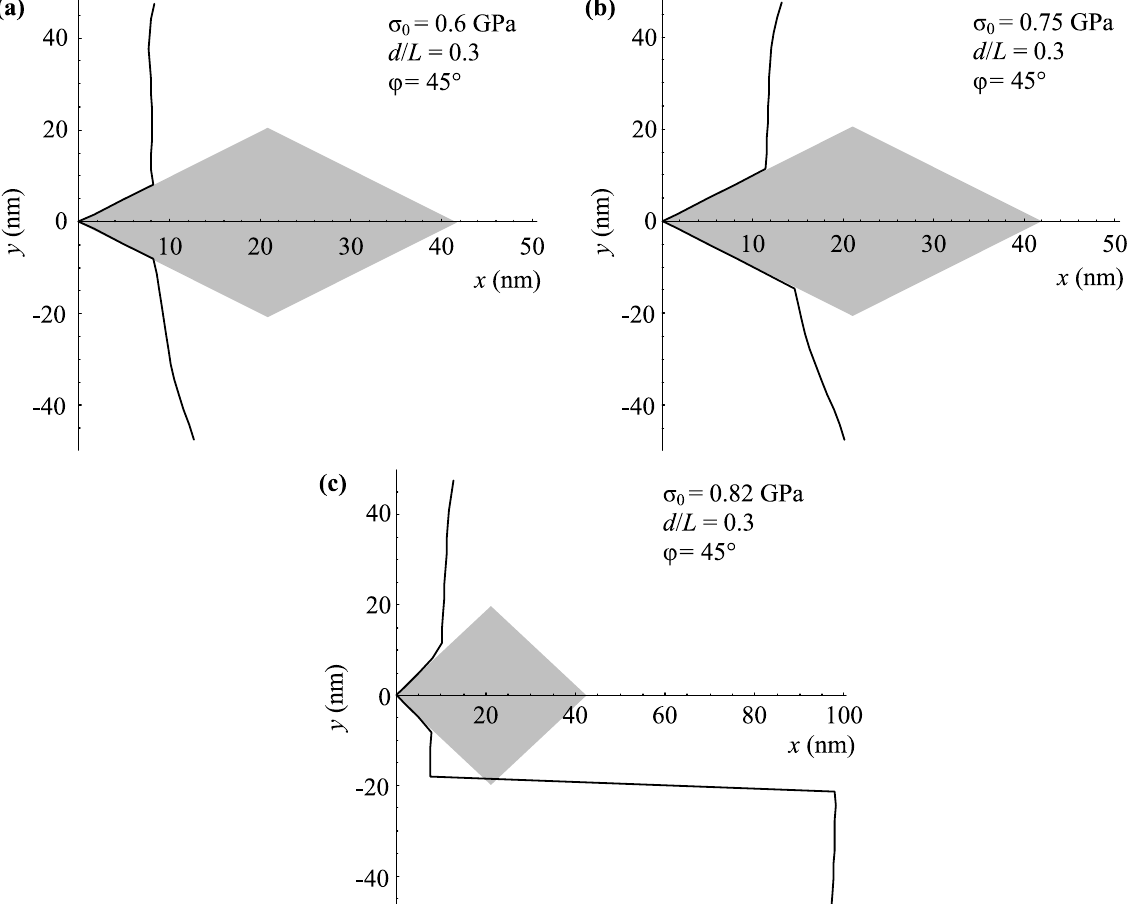
Fig. 4. Geometry of a migrating grain boundary that bends around a nanoinclusion at various values of applied stress calculated for angle  = 45 ° . (a), (b) Equilibrium profiles of a migrating grain boundary. (c) Nonequilibrium profile of a migrating grain